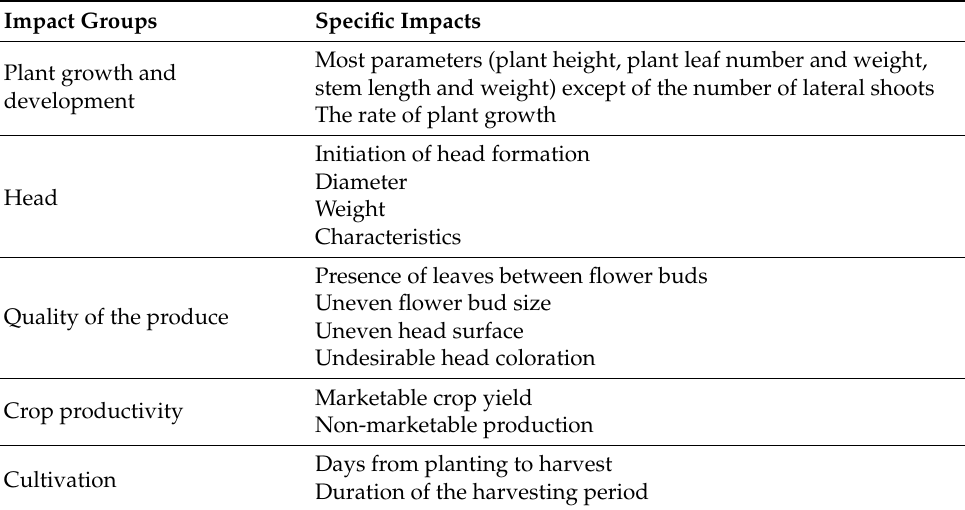
Figure 1. The number of days from crop establishment to start and end of harvest of three F1 broccoli hybrids (Cigno, Principe and Domino) based on their seed handling company (Company) and their field cultivation under normal conditions (NT) and of high temperatures (HT) at the Farm of the University of Thessaloniki. The cultivations were established on June 7 (HT) and August 4, 2021 (NT). The average air temperature was 27.8 ± 0.07 and 23.4 ± 0.55 °C in the first (HT) and second (NT) periods, respectively, for the F1 Cigno hybrid, 26.2 ± 1.08 and 20.9 ± 0.57 °C for the F1 Principe hybrid and 26.3 ± 1.18 and 20.9 ± 0.57 °C for the F1 Domino hybrid. Table 2. High temperatures cause a wide range of changes in the plant morphology, cultivation, as well as the yield and quality of the